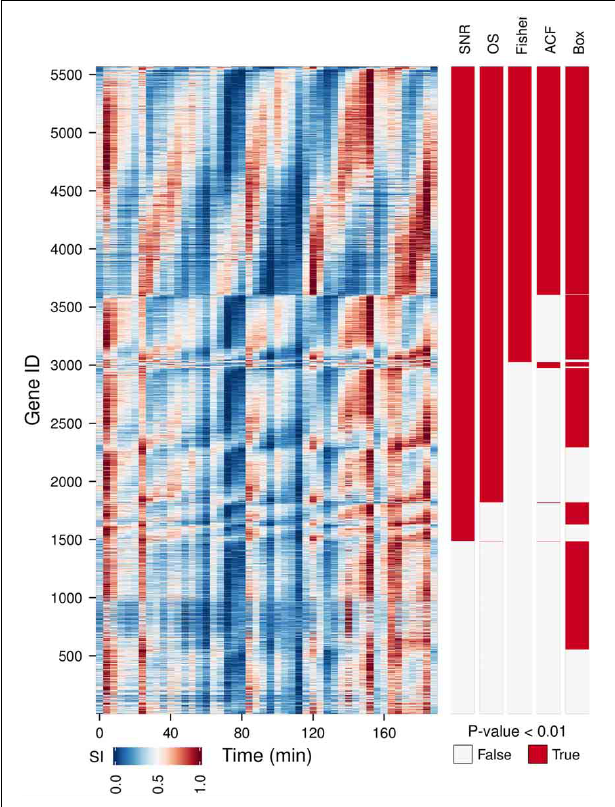
FIGURE 2 | A comparison between different oscillation tests. An oscillatory transcriptome dataset (Li and Klevecz, 2006) containing 5570 gene expression profiles during a perturbation experiment (injection of 1mM phenelzine at min 48) was used to test five oscillation metrics: signal-to-noise ratio (SN ratio) (Yamada and Ueda, 2007; Lehmann et al., 2013), oscillation strength (OS) (Murray et al., 2007), Fisher’s exact g -test (Fisher) (Ahdesmäki et al., 2005), autocorrelation function (ACF) (Venables and Ripley, 2002), and the Ljung box-test (Box) (Ljung and Box, 1978). Gene IDs were first sorted according to common hits ( P -value < 0.01 for SN ratio, OS, Fisher on period 4 and for ACF and Box on lag 12) and then by the phase angle of the dominant frequency of the data (4 cycles). The temporal profile of each gene was scaled (SI) for visualization